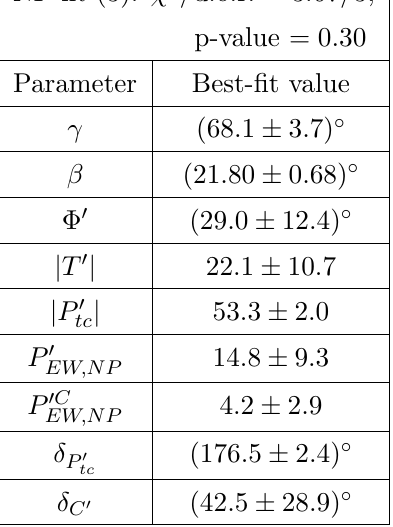
Table 9 . (cid:31) 2 = d : o : f : and best-(cid:12)t values of unknown parameters for the Z 0 model where only min g dd is nonzero. Constraints: B ! (cid:25)K data, measurements of (cid:12) and (cid:13) , j C 0 =T 0 j = 0 : 2, R j P 0 C =P 0 j = 0 : EW;NP EW;NP